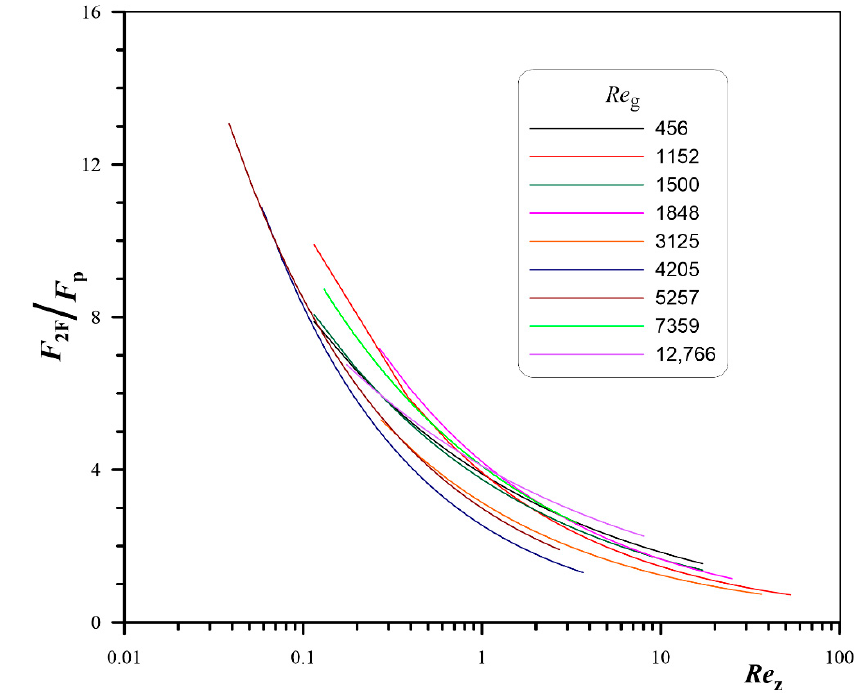
Figure 14. Influence of flow parameters on the relative value of the interface surface.